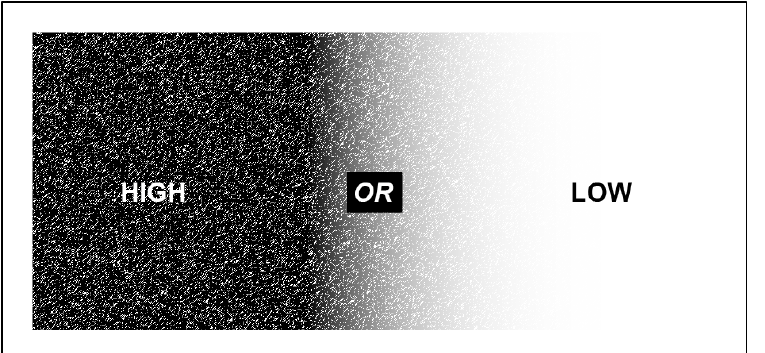
Figure 3. Mode of Impact—Visibility. The second mode of impact is visibility. It examines the degree to which a negative externality is observable and measurable. An example of a negative externality with high visibility is increased slum development; an example of a negative externality with low visibility is decreased groundwater table and quality.